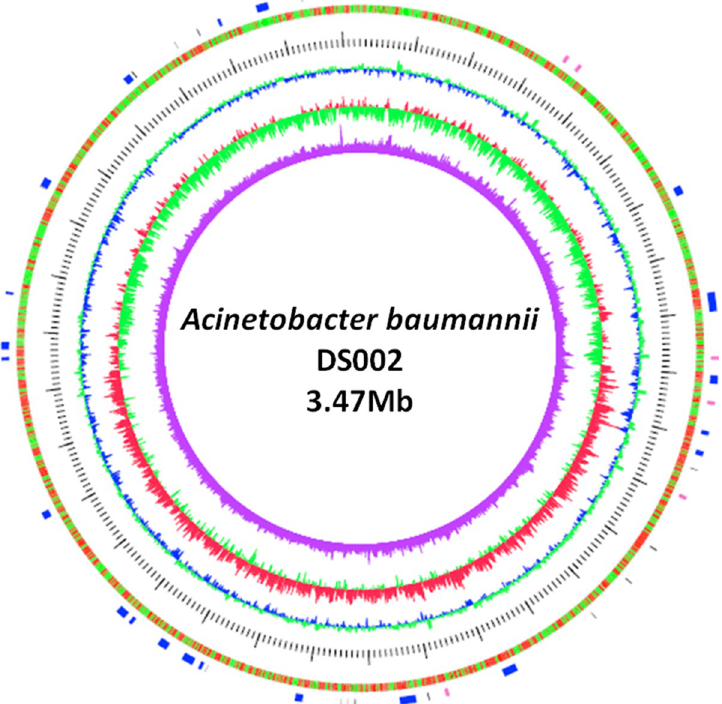
Fig 1. Circular map of the chromosome. Circle 1 (outer to inner) represents the total 3251 CDS in the genome. Genes present on the positive and negative strands are depicted in red and green colour, respectively. Circles 3, 4 and 5 represent GC content, GC skew, and dinucleotide bias, respectively. The tRNA (black) and rRNA (red) coding genes and the genomic islands (blue) are shown in the outermost discontinuous